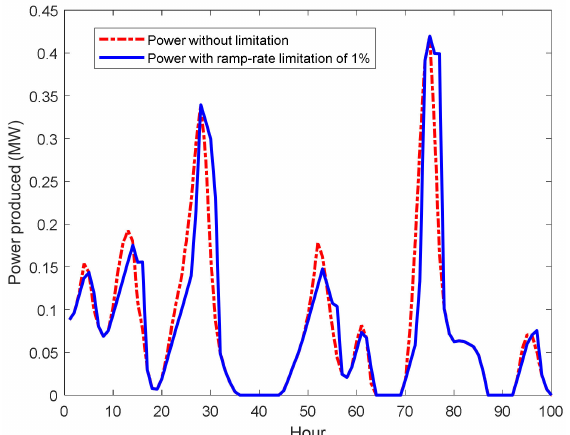
Figure 6. One hundred hour power profile sample with and without ramp-rate limitation with and 3 batteries.